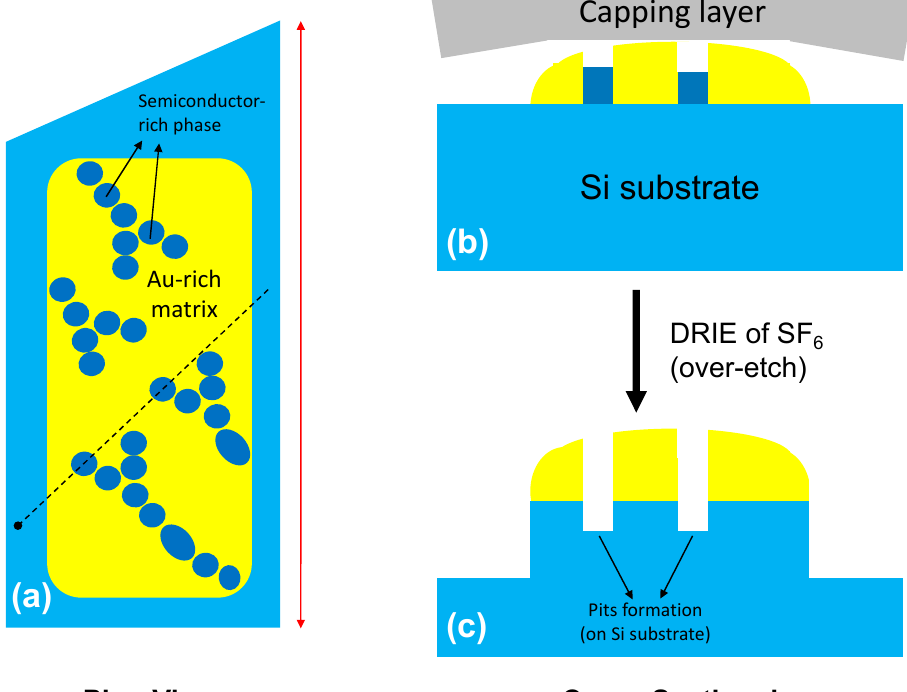
Figure 9. ( a ) A cross-sectional TEM image showing the formation of a Si nanostructure. ( b ) A higher resolution TEM image of the formed nanostructure showing its epitaxial relationship with the un- derlying Si substrate. The presence of Ge, as indicated by the EDS data in Figure 5f, on the micro-crucibles with a large opening suggests the possible nucleation of Ge crystals in this type of micro- crucible using the CVD growth conditions (4 sccm of GeH 4 , 40 mTorr, and 375 °C for 1 h).